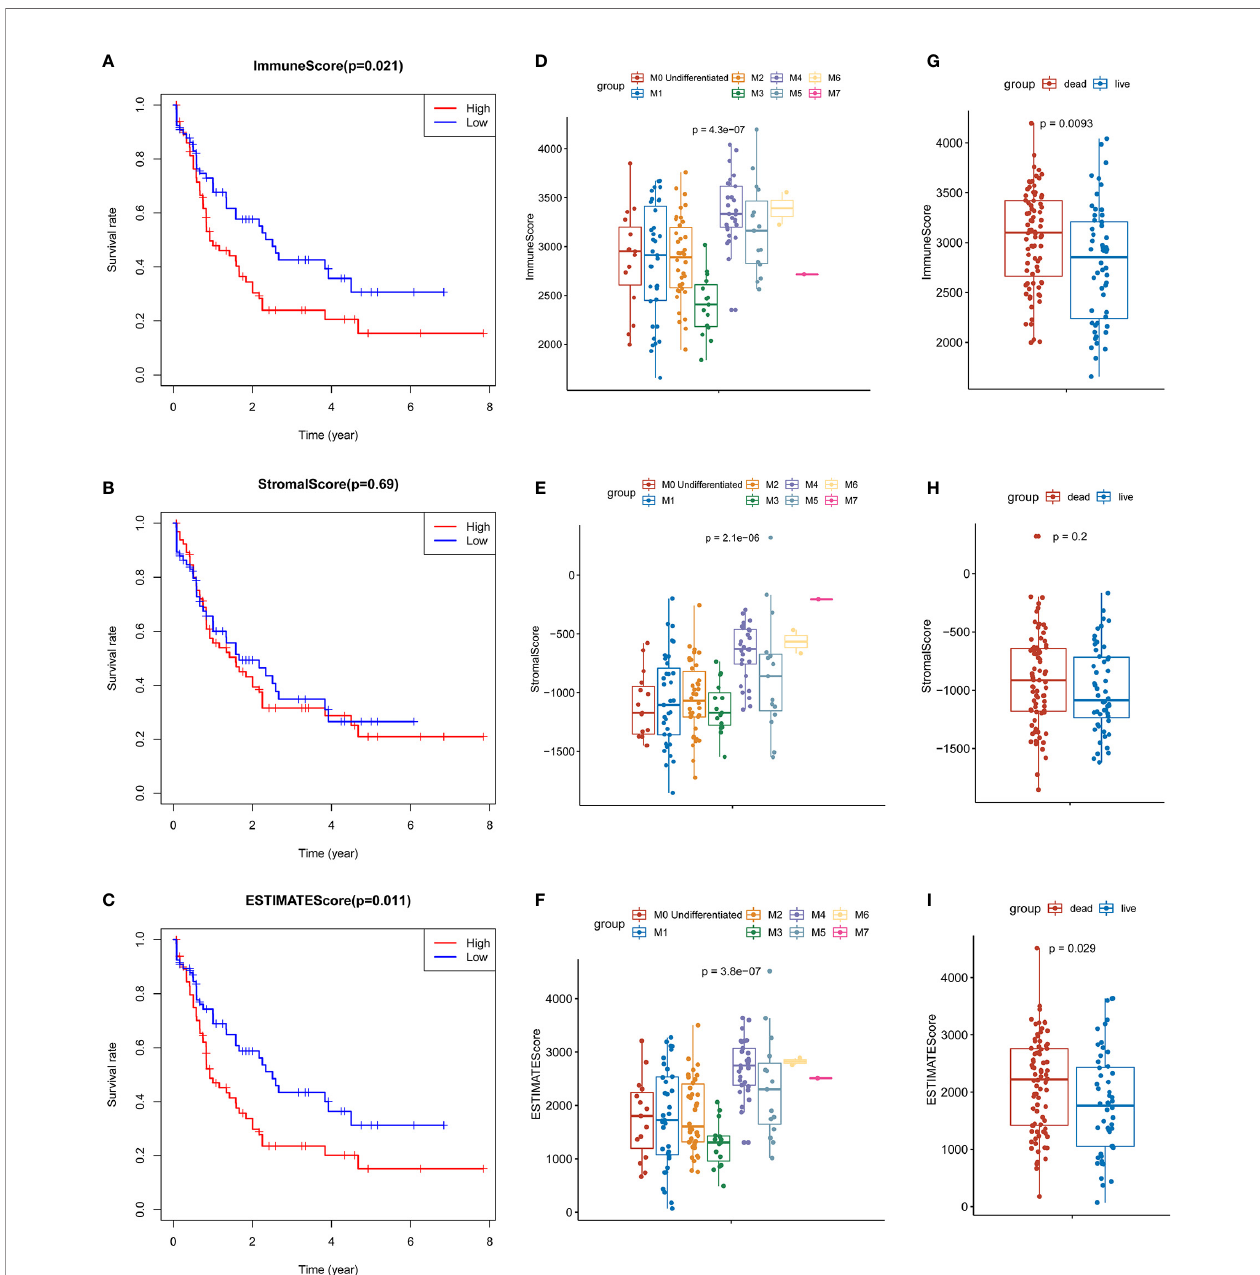
FIGURE 1 | Identi fi cation of the relationship between TME scores and prognosis of AML. (A) Survival curve of high and low immune groups: the survival rate of patients with high immune scores was signi fi cantly reduced (P = 0.021). (B) Survival curves of high and low stromal groups: the survival rate of patients with high stromal score decreased, with no signi fi cant statistical difference (P = 0.69). (C) Survival analysis showed that the survival rate of patients with high ESTIMATE score was signi fi cantly reduced (P = 0.011). (D – F) The distribution of the three scores in different FAB classi fi cations are signi fi cantly different (all P values < 0.0001); (G – H) The relationship between the survival status of AML patients and three scores: the immune scores of the dead cases (P = 0.0093) and the ESTIMATE scores (P = 0.029) were signi fi cantly higher than those of the surviving patients, and the patients with high stromal scores were more likely to be in the state of death, but there was no signi fi cant statistical difference (P =